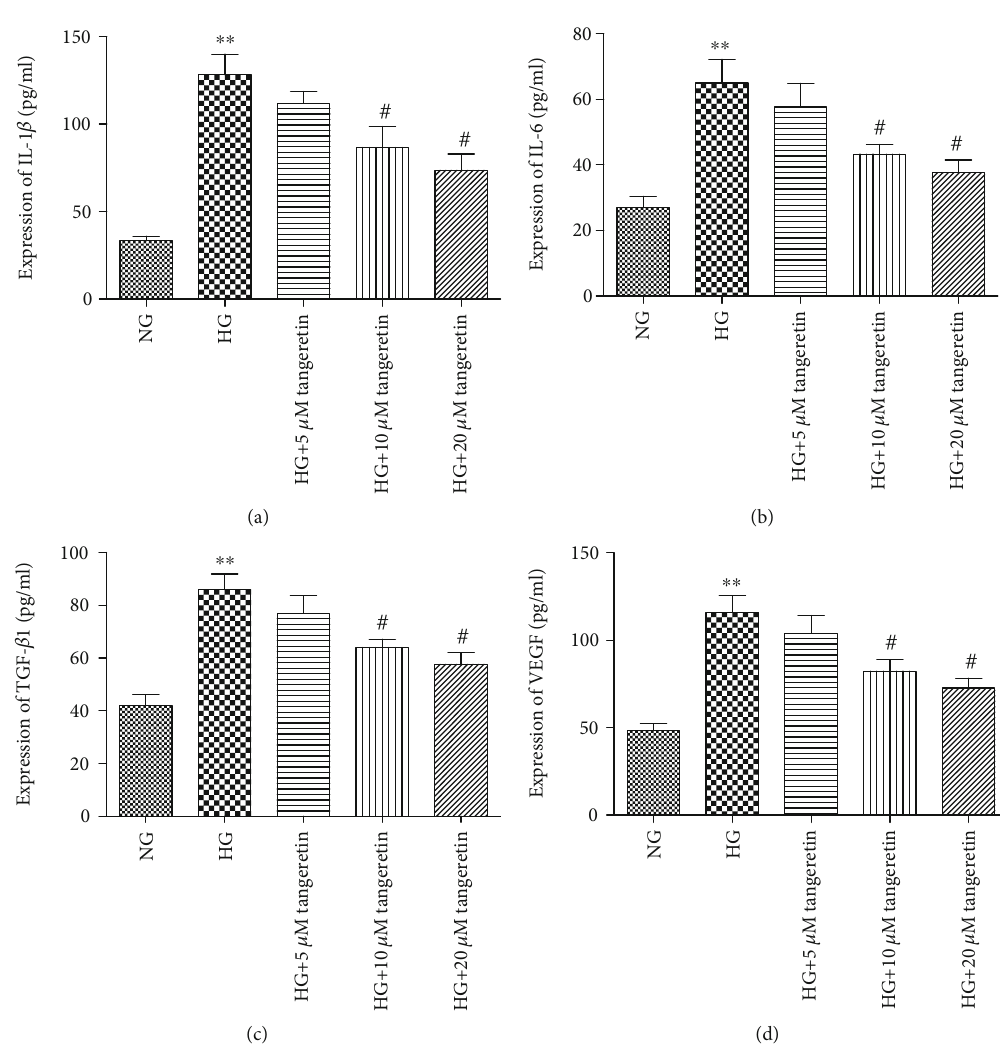
Figure 5: Tangeretin decreased the protein level of IL-1 β , IL-6, TGF- β 1, and VEGF in RPE cells. After pretreatment with various concentrations of tangeretin (5 μ M, 10 μ M, and 20 μ M) for 1 h, RPE cells were stimulated by the addition of HG (30mM) for 24 h. An ELISA kit analysis was performed to assess the protein level of IL-1 β , IL-6, TGF- β 1, and VEGF. Tangeretin signi fi cantly decreased the HG-induced protein (a – d) levels of IL-1 β , IL-6, TGF- β 1, and VEGF in RPE cells in a dose-dependent manner. Values are expressed as the mean ± SD of three independent experiments. ∗∗ p < 0 : 01 versus NG; # p < 0 : 05 versus